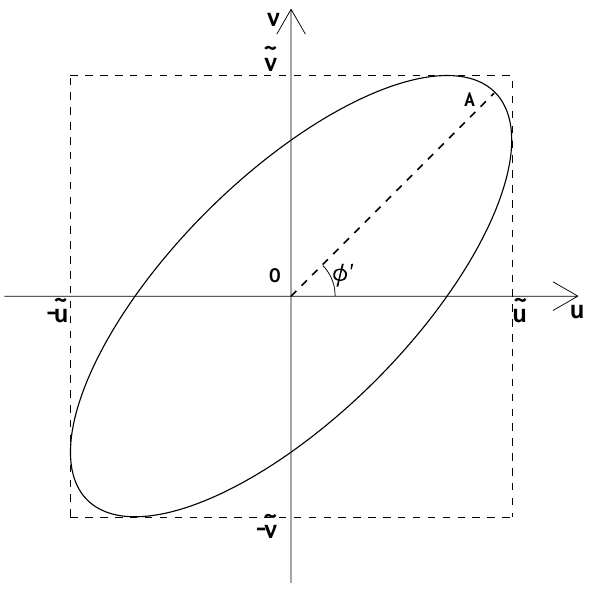
Fig. A1. Schematic of wind perturbation hodograph for a monochromatic gravity